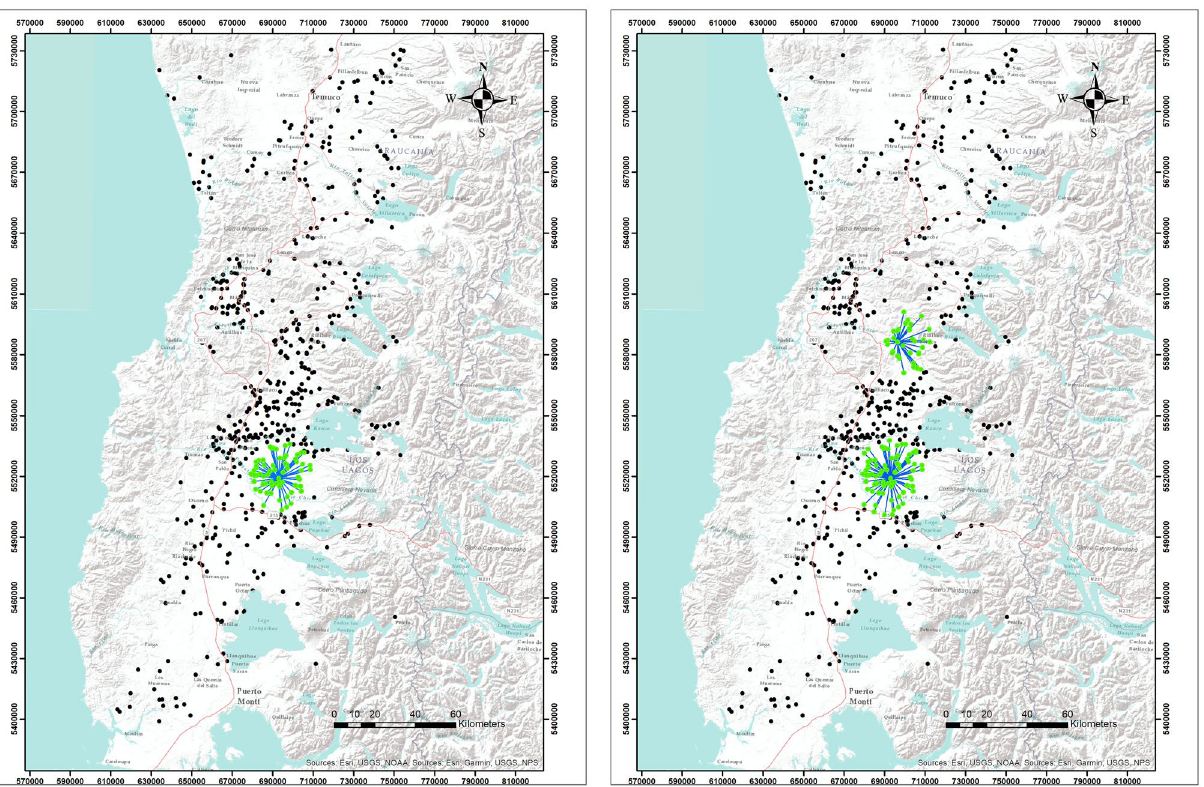
Fig. 6 Location of the configurations of the best combination, with 40% biomass availability scenario, transport cost of 0.3 USD/tkm and energy price of 98 (left) and 100 (right)